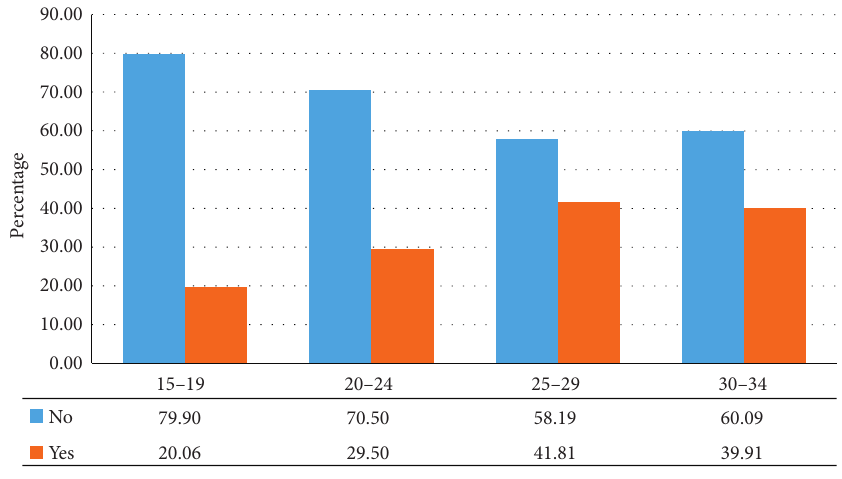
Figure 1: Percentage distribution of hypertension status (yes/no) by age group of the respondents, South Africa, 2016.